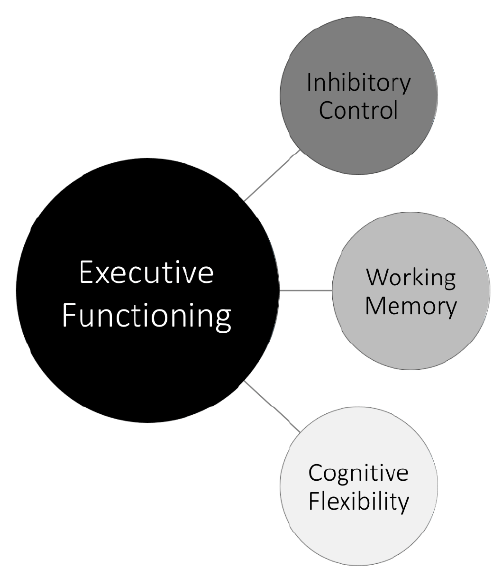
Figure 1. An illustration of the three core executive functions [26]. This theory of executive function- ing proposes that there are three related, but distinct, aspects of executive functioning: inhibitory control, working memory (i.e., updating), and cognitive flexibility (i.e., shifting). Inhibitory control (IC) is characterized by one’s ability to exhibit mental control over their thoughts, feelings, and behaviors in order to override external distractors and rather engage with or in the more appropriate or necessary task [25]. IC is a critical skill required for on-task behavior in the face of distractions (e.g., studying for a test while ignoring notifications appearing on their phone or computer). WM necessitates the maintenance and manipulation of information in the mind [30]. WM is a process that is required to understand written and spoken language, perform mental mathematics, as well as reason or problem solve. For young people, working memory difficulties might make it challenging to remember a list of instructions for an assignment given by a parent, teacher, or coach. Lastly, cognitive flexibility involves the ability to change perspectives both spatially as well as in social contexts [19]. For children and adolescents, a deficit in cognitive flexibility might present as difficulty in altering expectations and/or coping with changes in routines or